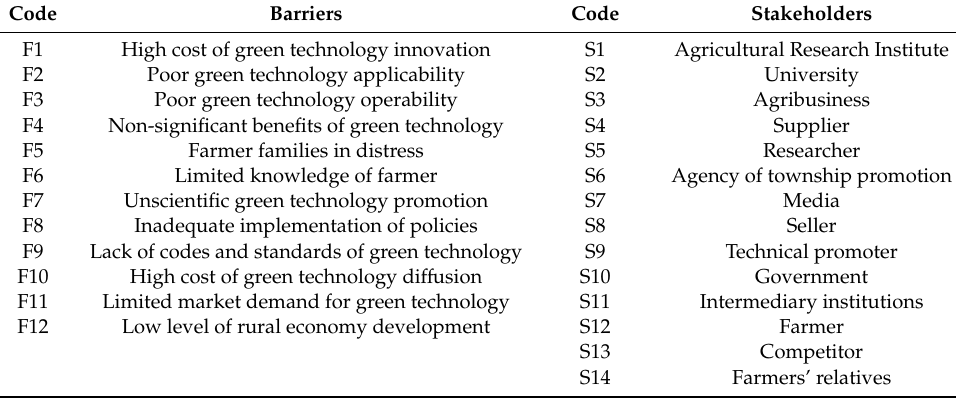
Table 1. Barriers and stakeholders a ff ecting agriculture green technology di ff usion.